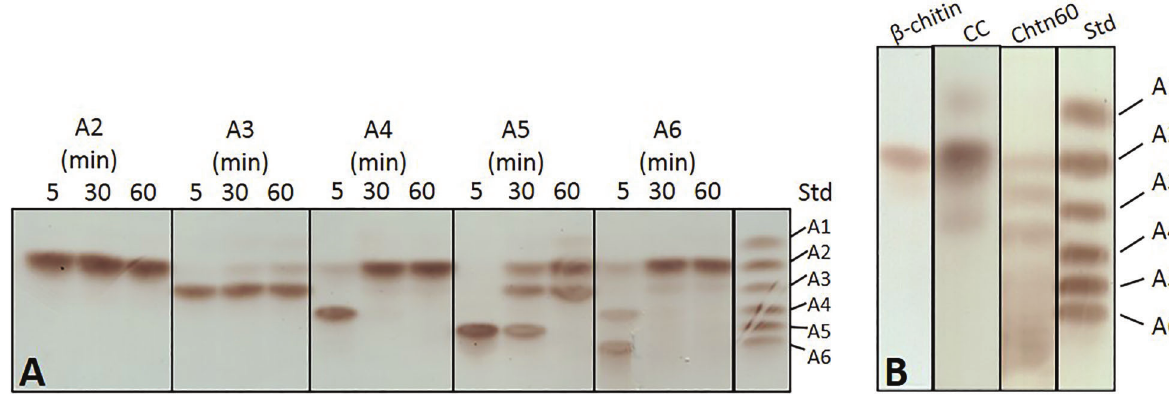
Figure 5. Products of MetaChi18A activity on different substrates: chitooligomers (A2 – A6) and polymers; b -chitin, colloidal chitin (CC) and chitosan 60% acetylated (Chtn60). MetaChi18A hydrolysis products were separated by thin-layer chromatography. A , Reaction with 0.76 ng/ m L MetaChi18A, 1.25 g/L oligomers in 100 mM MES buffer, pH 5, at 50°C for 5, 30, and 60 min. B , reaction with 1 ng/ m L MetaChi18A, 1 g/L b -chitin, CC or Chtn60 in 10 mM ammonium acetate buffer, pH 5, at 50°C for 24 h.